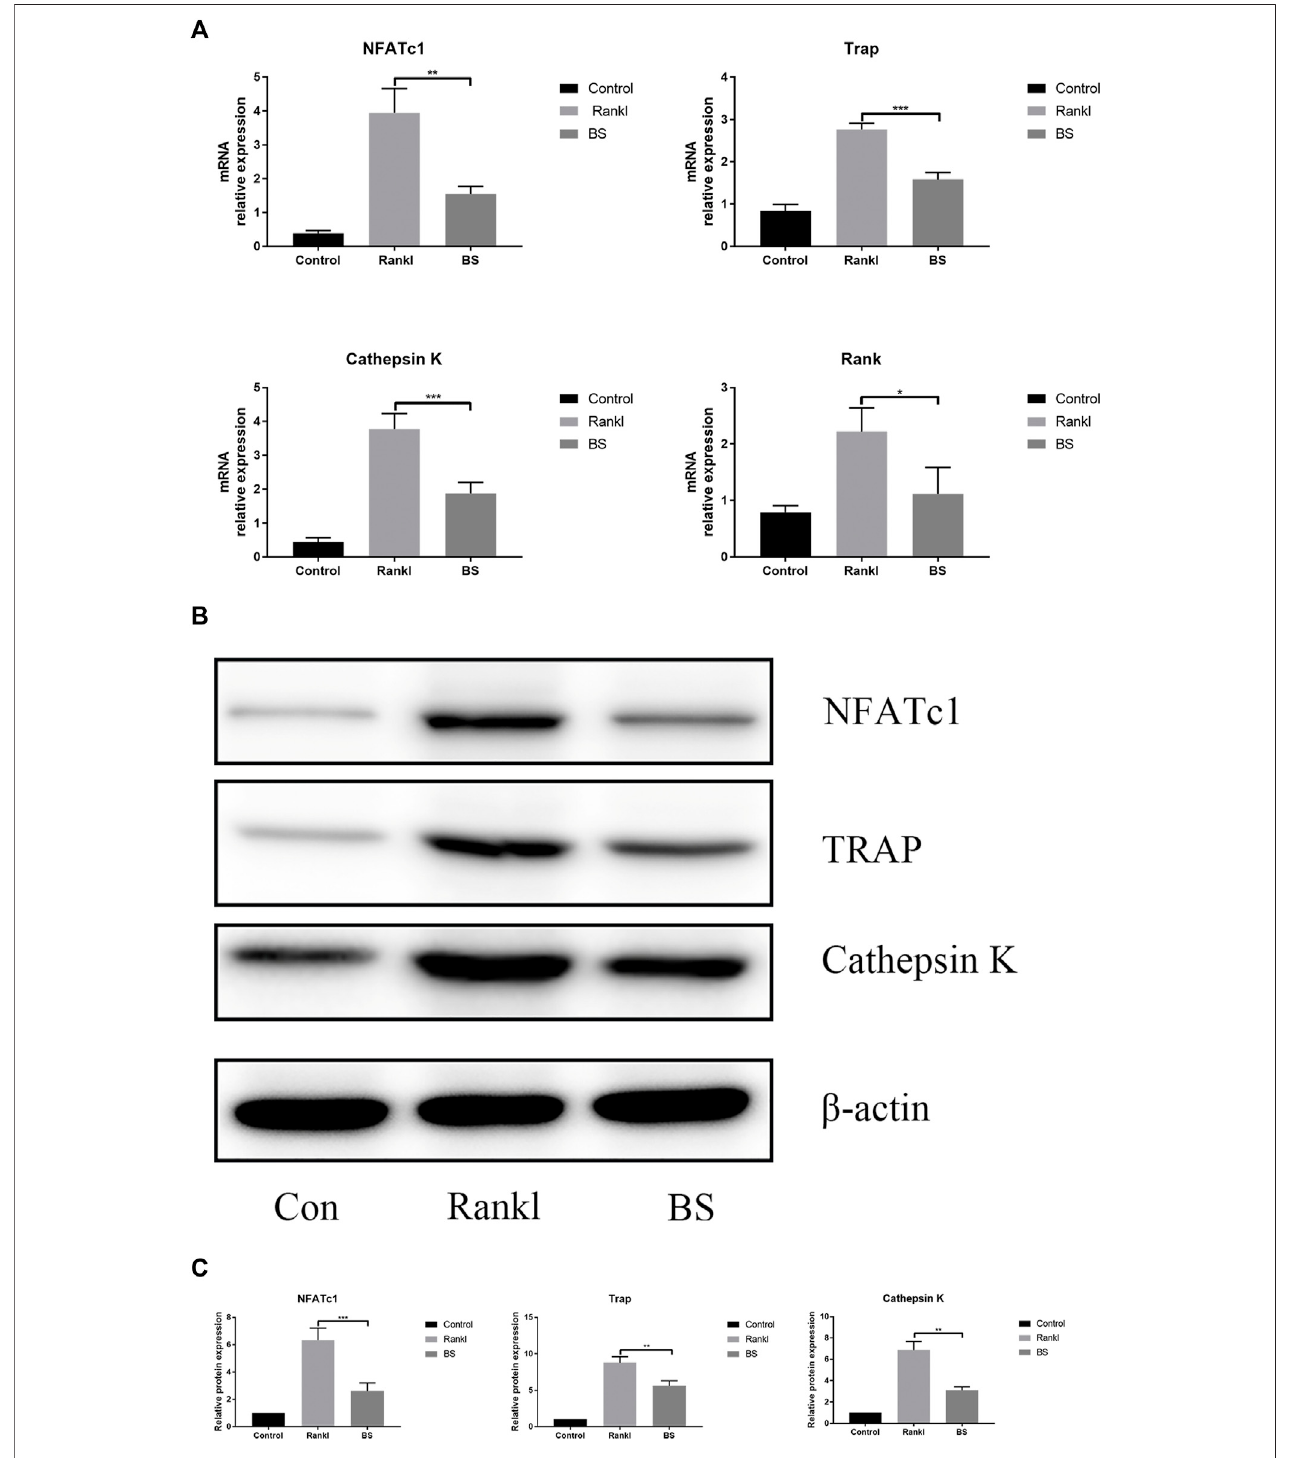
FIGURE6| BSabrogatesRANKL-associatedNFATc1activationanddownregulatesosteoclast-relatedgenes. (A) NFATc1,TRAP,Rank,andCathepsinKmRNA level. (B) Representative western blot of NFATc1, TRAP, and Cathepsin K in BS-treated BMMs. (C) Quantitative analysis of NFATc1, TRAP, and Cathepsin K. All bar graphs are presented as mean ± SD; n = 3. p p < 0.05; pp p < 0.01; ppp p < 0.001.